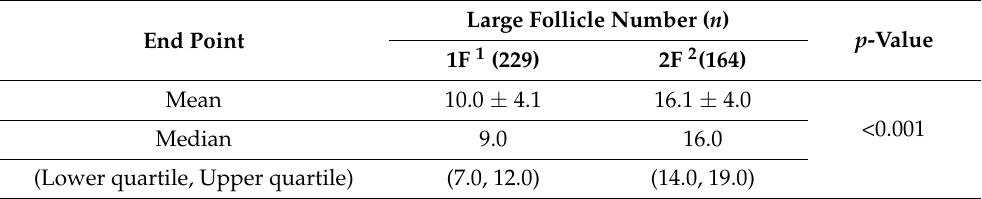
Table 1. Differences in mean and median days from the latest estrus to the ovarian examination between 1F 1 and 2F 2